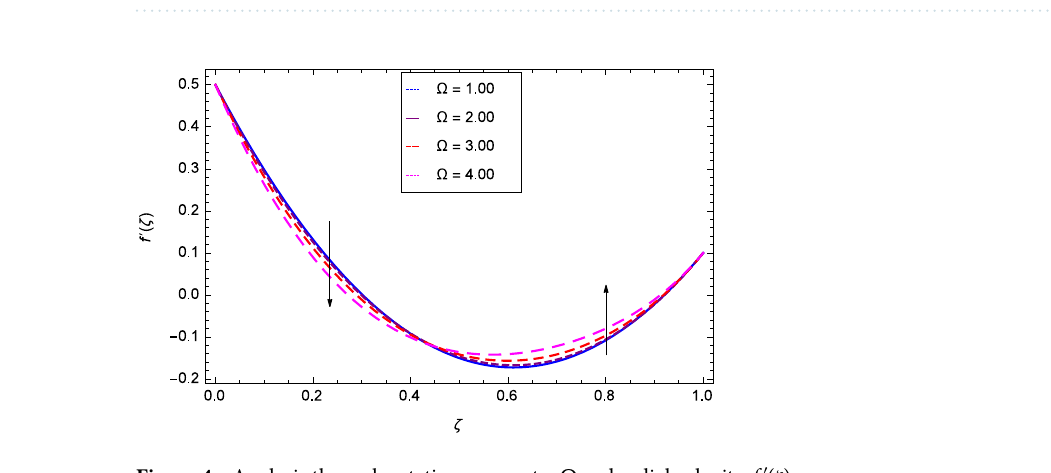
Figure 3. Analysis through magnetic field parameter M and radial velocity f ′ ( ζ ).